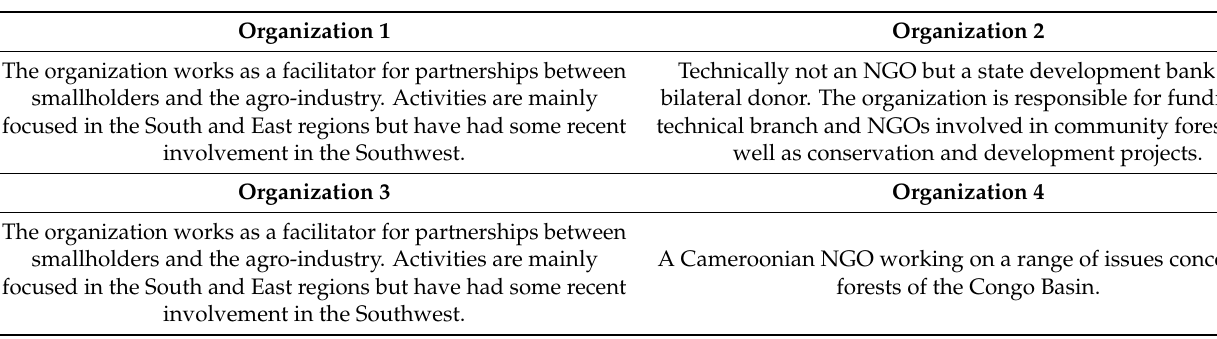
Table 3. Summary of NGOs